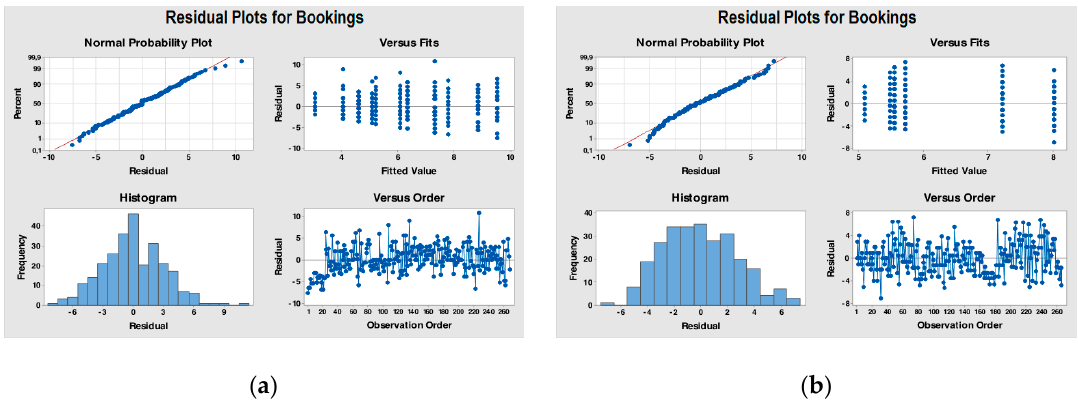
Figure 3. ( a ) Residual Plots for the variable “bookings” grouped according to the factor “month”; ( b ) Residual Plots for the variable “bookings” grouped according to the factor “day”. Visual inspection of the normal probability plot and the histogram seems to indicate that the residuals follow a normal pattern for both.